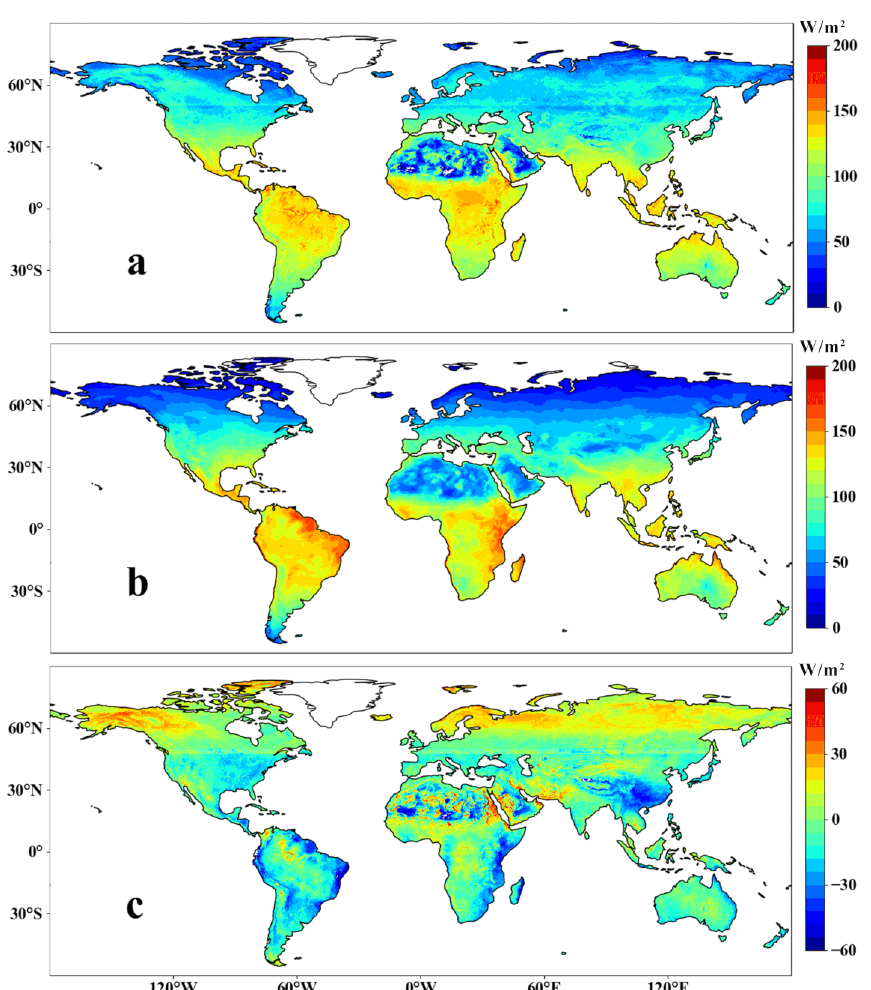
Figure 3. Spatial patterns of average annual Rn (W / m 2 ) of GLASS Rn ( a ) and MERRA-2 Rn ( b ) in the period from 2007 to 2017 and their difference (GLASS-MERRA-2, ( c )).